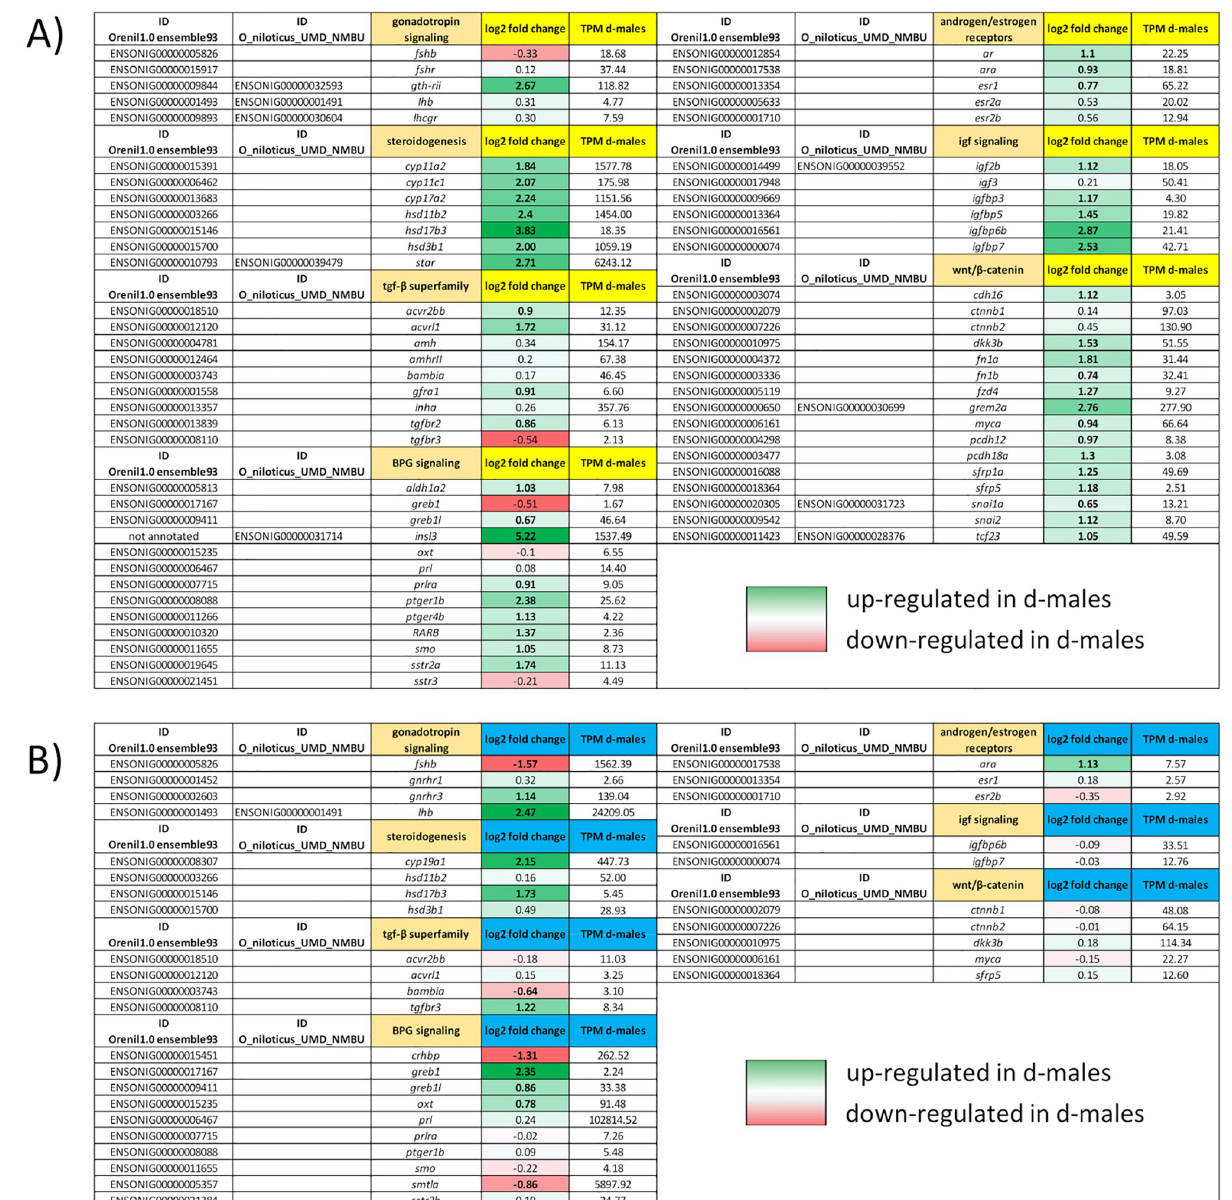
Fig 4. Gene expression in testes and pituitaries of dominant and subordinate Nile tilapia. Expressions of selected genes as measured by RNA-Seq for testis (A) and pituitary (B) with log2fold change and TPM (transcripts per million). Bold face indicates significant regulation (DEG) with adjusted p-value (pjad) < 0.05. In case the original (Orenil1.0ensembl93) Ensembl gene IDs have retired in the current annotation (O_niloticus_UMD_NMBU), both IDs are